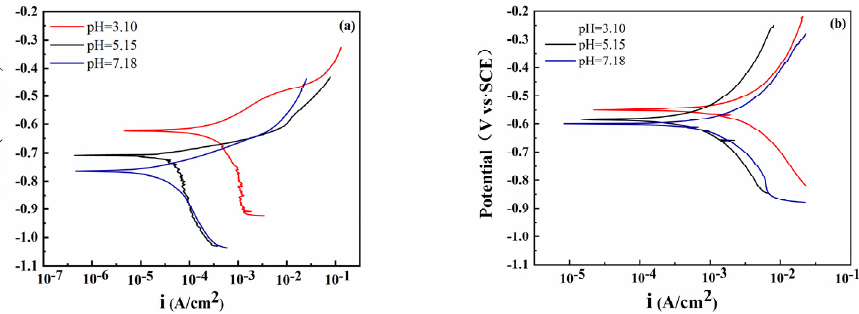
Figure 1. Potentiodynamic polarization curves with 3.5% NaCl at different pH values: ( a ) bare steel, ( b ) S8-coated steel.